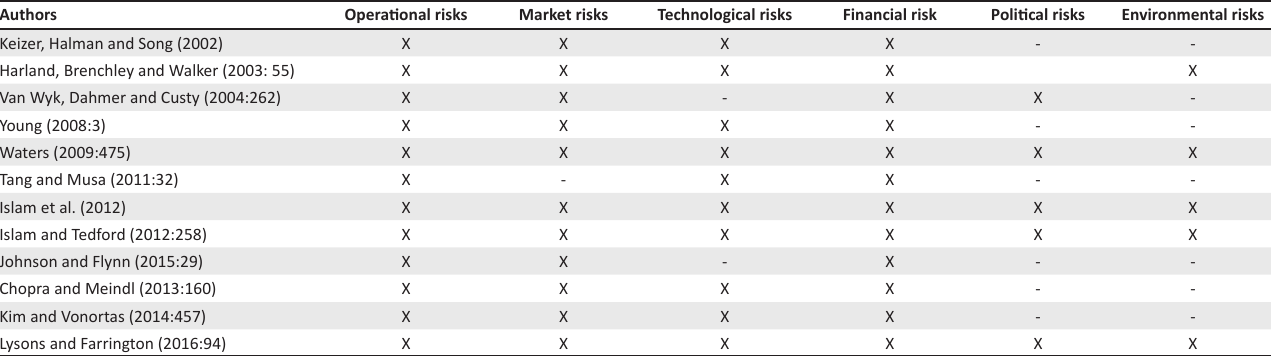
TABLE 2: Categories of